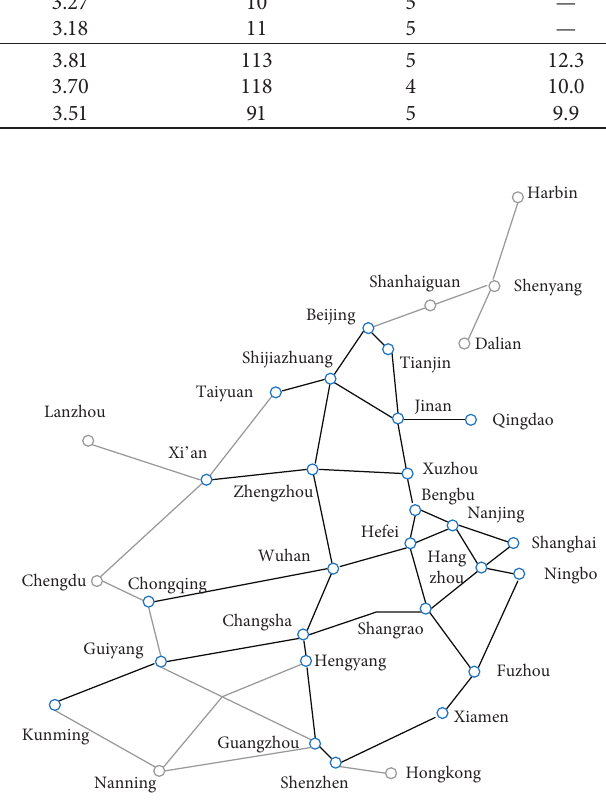
Figure 6: The topology of the medium (only black edges) and large (the black and grey edges) HSR network.